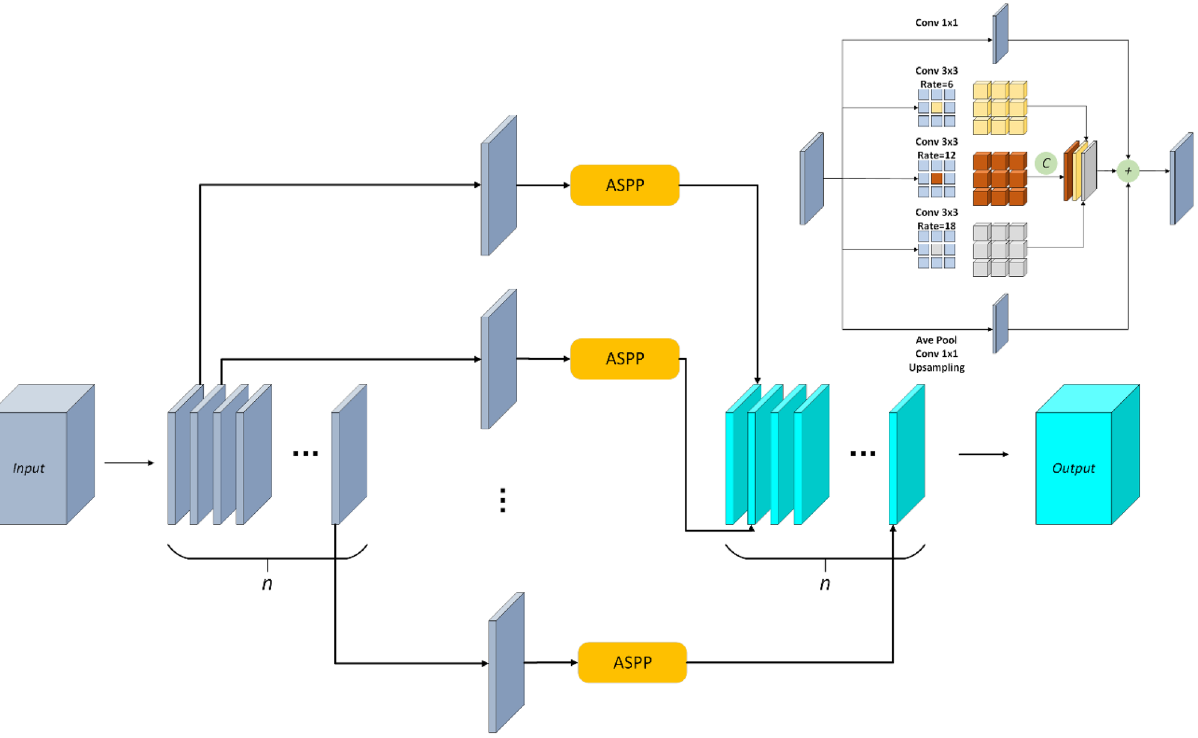
Figure 5. Structure of multiple pyramid